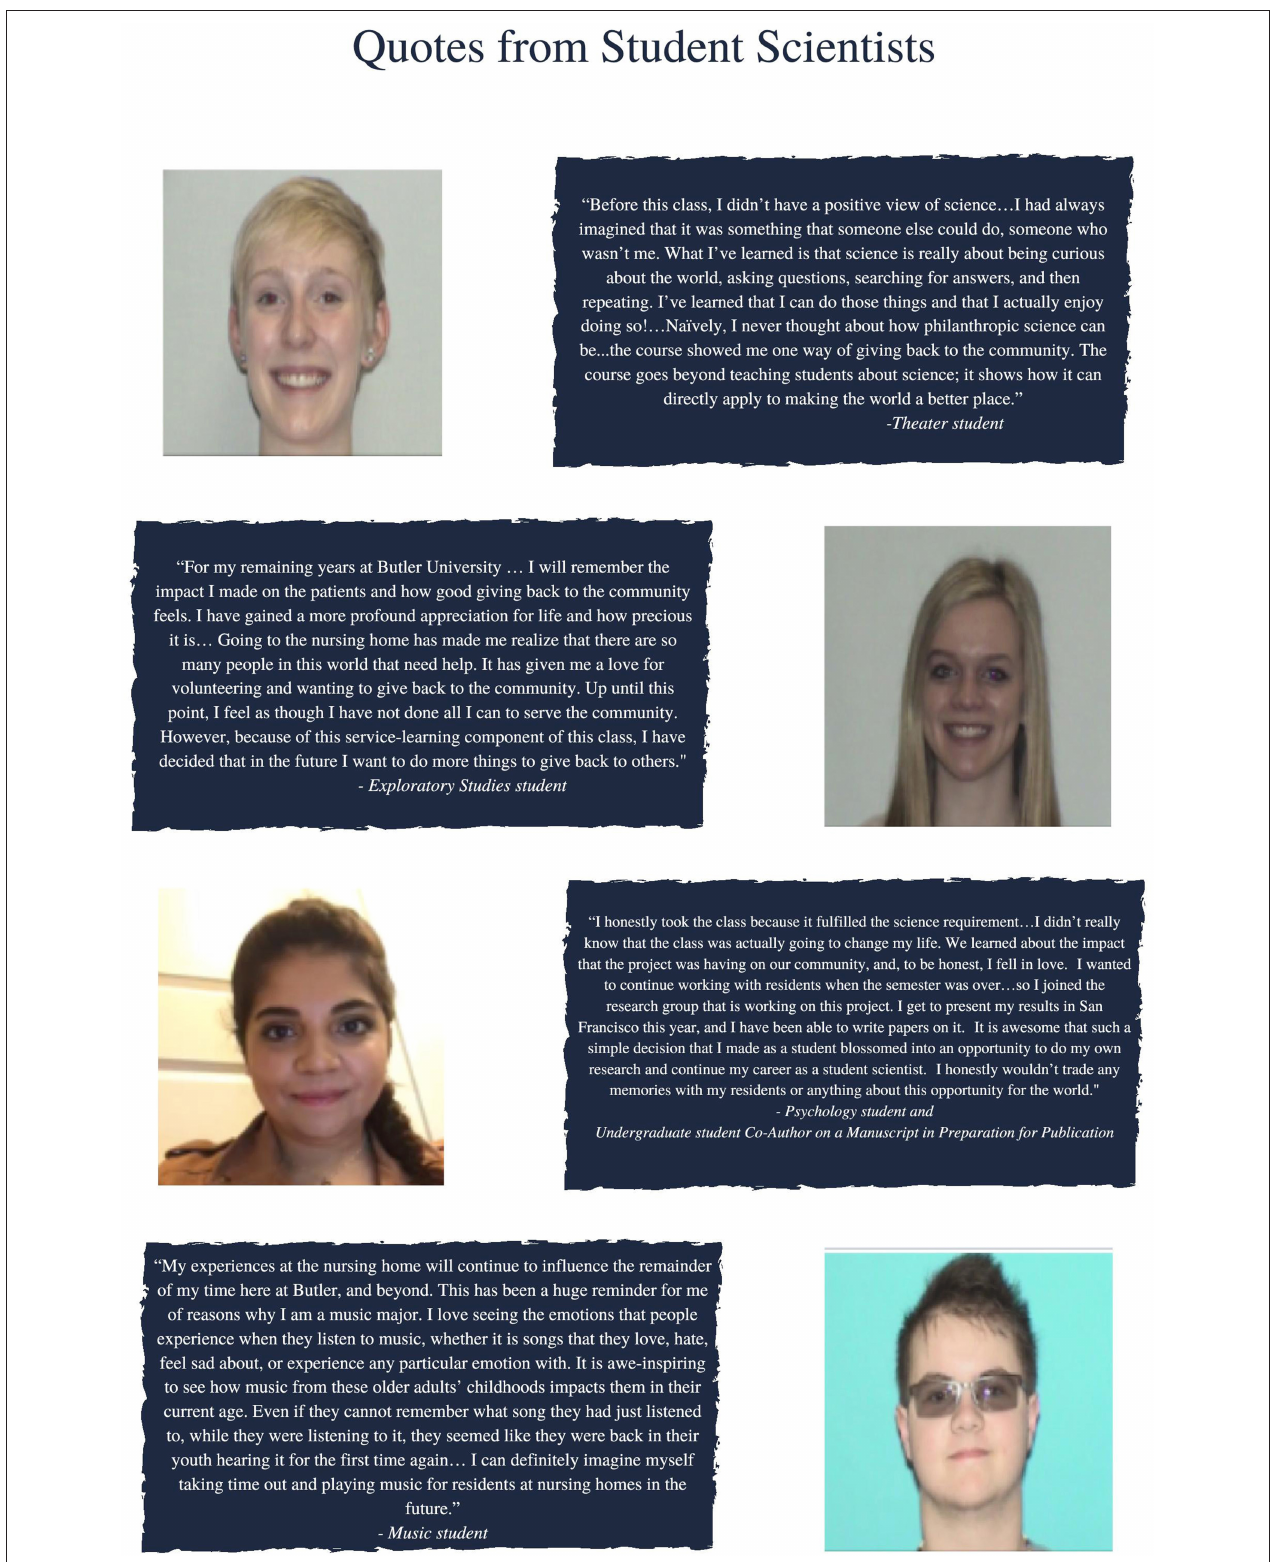
FIGURE 1 | Quotes from student scientists’ post-course reflections that demonstrate their enhanced appreciation of science, civic engagement, and their majors as a result of the course. Written informed consent was obtained from the individuals pictured in this figure for the publication of these images.